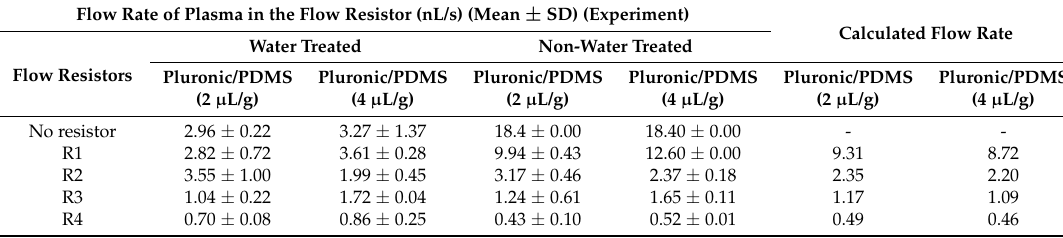
Figure 5. The flow rates of plasma in the entire LFD made of ( A ) Pluronic/PDMS (2 μ L/g); ( B ) Pluronic/PDMS (4 μ L/g).